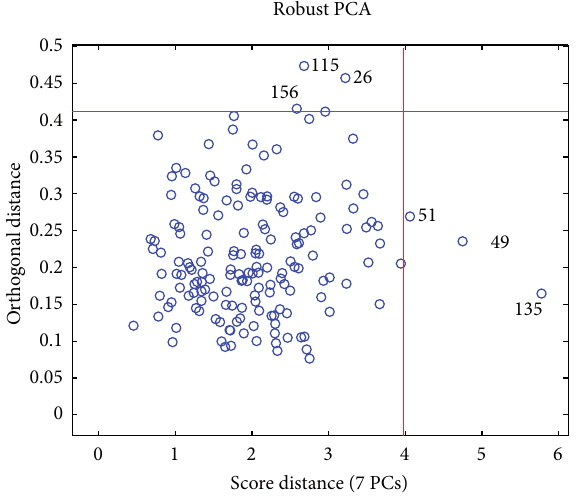
F 3: Outlier diagnosis plot obtained by robust PCA with 7 principal components of 167 Anji-white tea